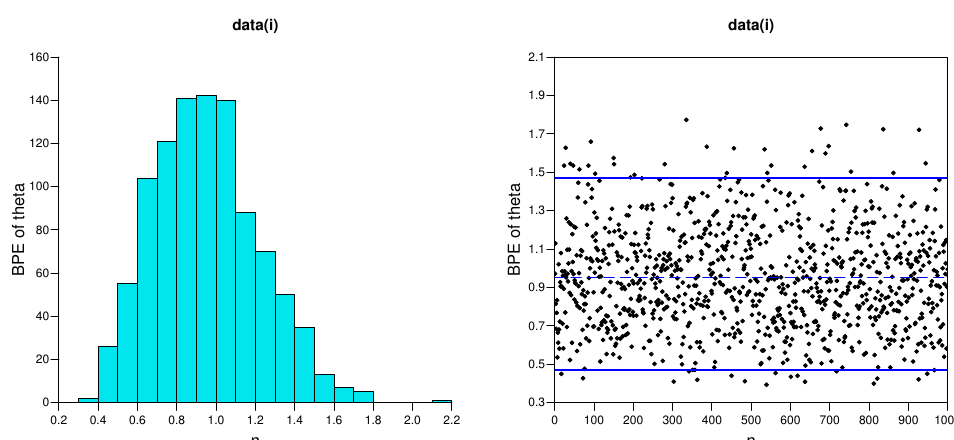
Figure 7. Trace plots (the posterior mean (dashed line) with 95% credible intervals (solid lines)) and corresponding histograms of BPEs of α and θ for data set I.